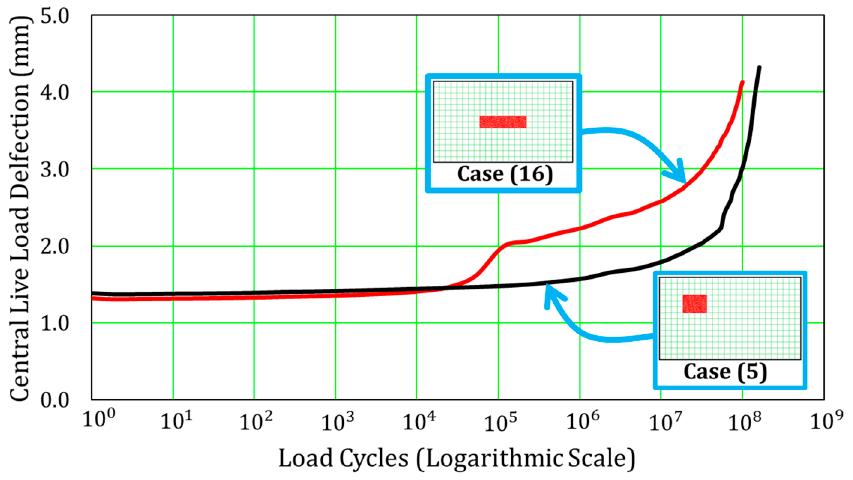
Figure 17. Load cycles and the central live load deflection of cases (5) and (16).